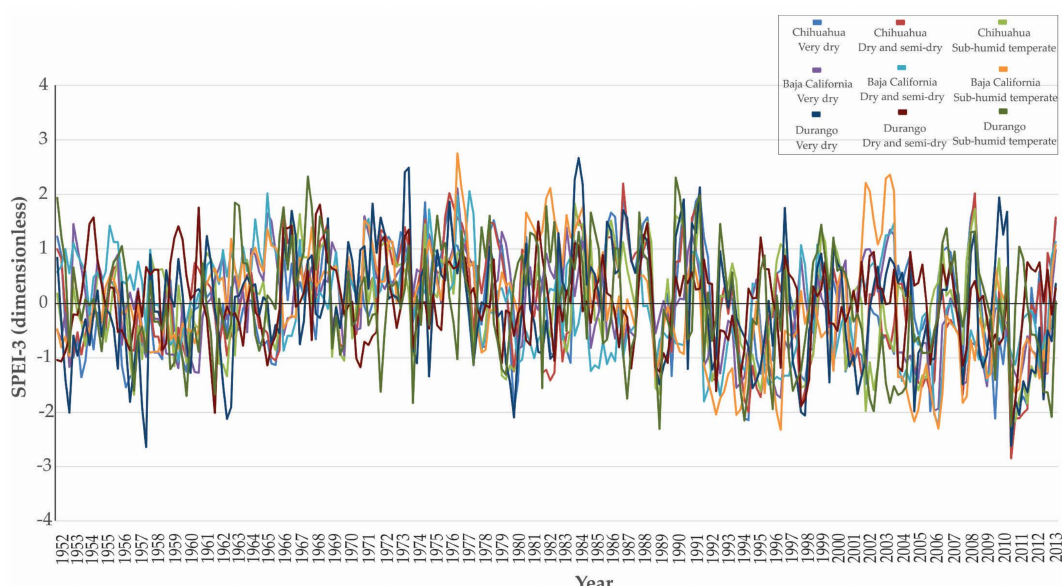
Figure 2. Seasonal variation of SPEI-3 by climate region in states in northern Mexico (Chihuahua, Baja California and Durango) in the period 1952–2013 (dimensionless). Source: Authors, following SPEI database (http://sac.csic.es/spei/) and INEGI climatic classification (http://www.cuentame. inegi.org.mx/monografias/).